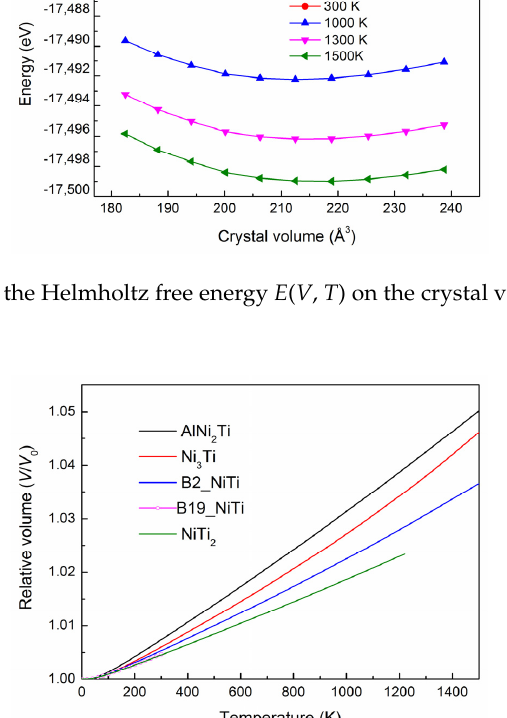
Figure 6. Volume expansions evaluated by V / V 0 as a function of temperature, where V 0 refers to the equilibrium volume at 0 K.